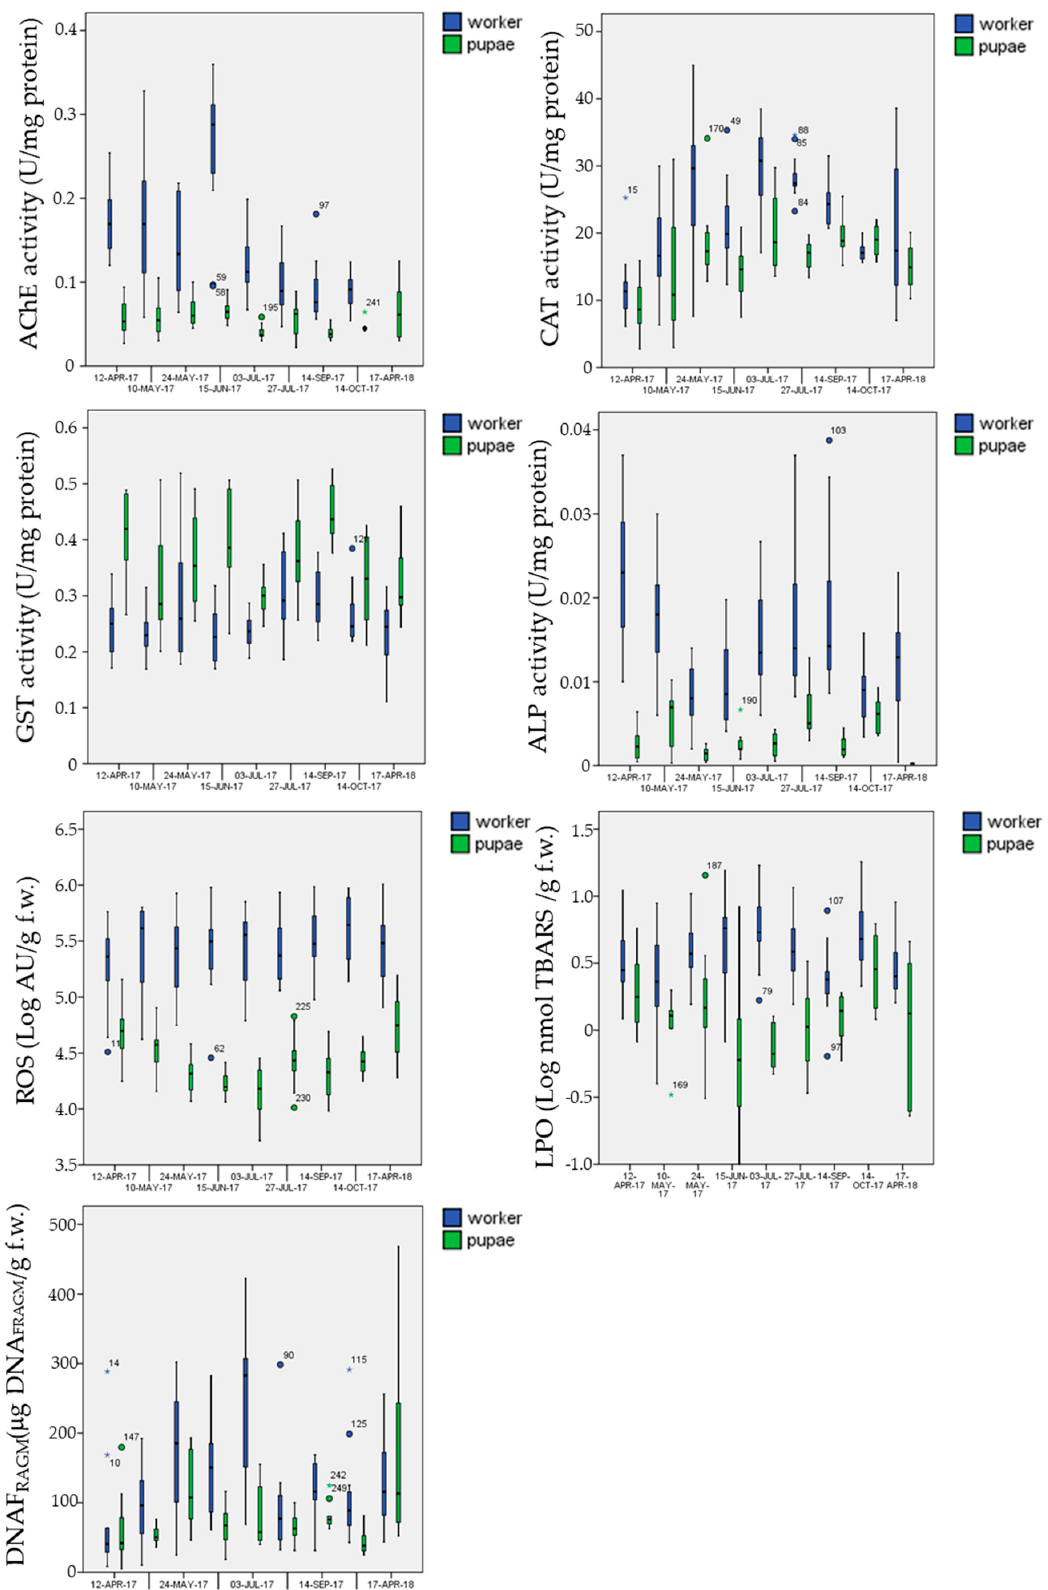
Figure 7. Box-plots of the analyzed biomarkers in the control site as a function to the sampling date.